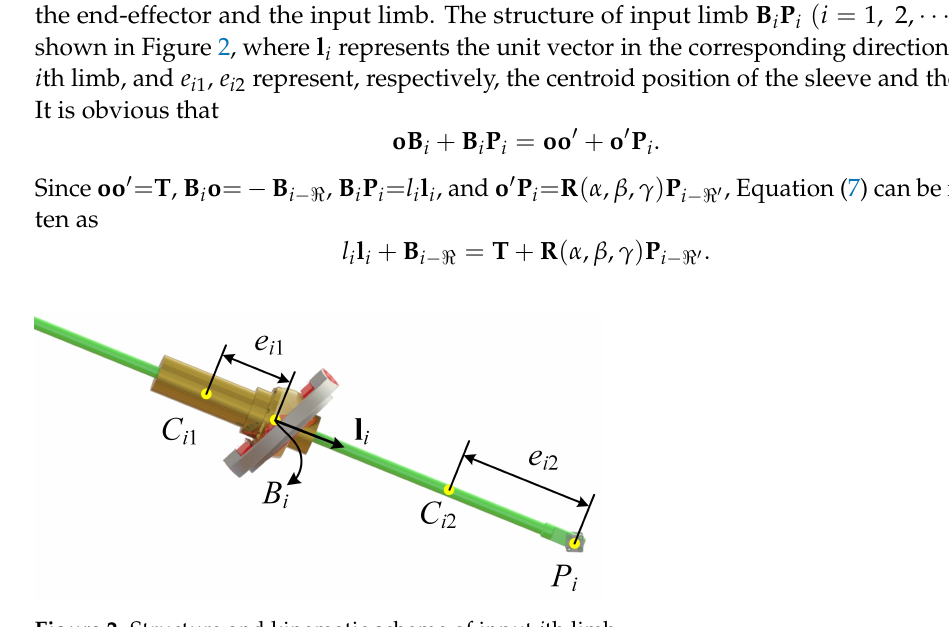
Figure 2. Structure and kinematic scheme of input i th